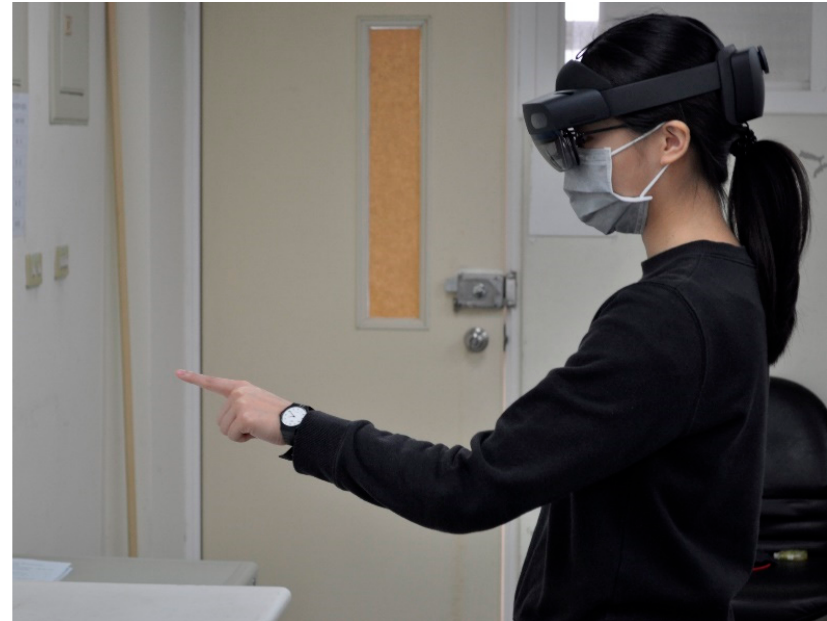
Appl. Sci. 2023 , 13 , 788 Figure 3. Pointing task on virtual keys wearing the Hololens device. Figure 3. Pointing task on virtual keys wearing the Hololens device.